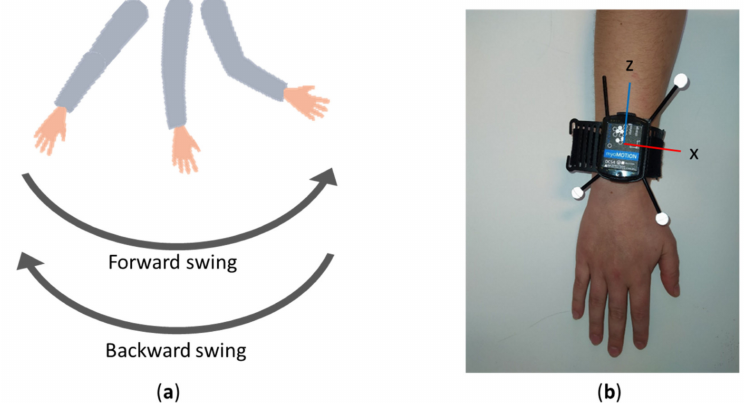
Figure 1. ( a ) Definition of swings. ( b ) Placement and orientation of the right-handed coordinate system of inertial measurement unit and reflective